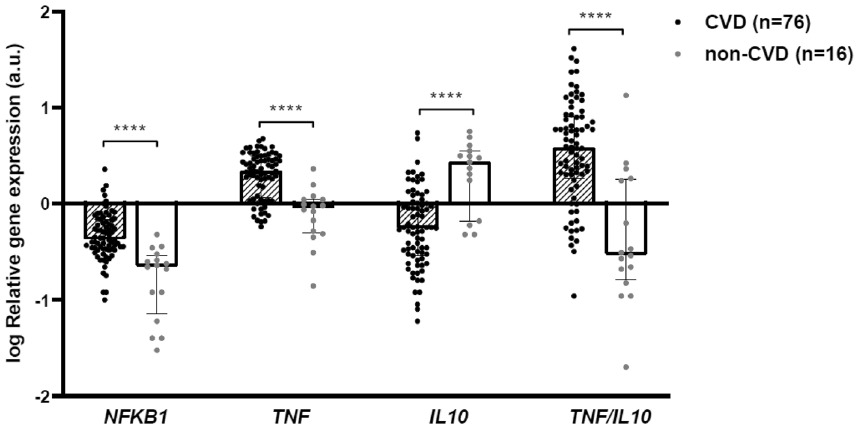
Figure 1. Inflammatory markers in PBCCs of CVD and non-CVD subjects. Relative gene expression levels of NFKB1, TNF and IL10 loci and their ratio. a.u.: arbitrary units. Bars and range represent median and IQR. ***: P < 0.001; ****: P < 0.0001.